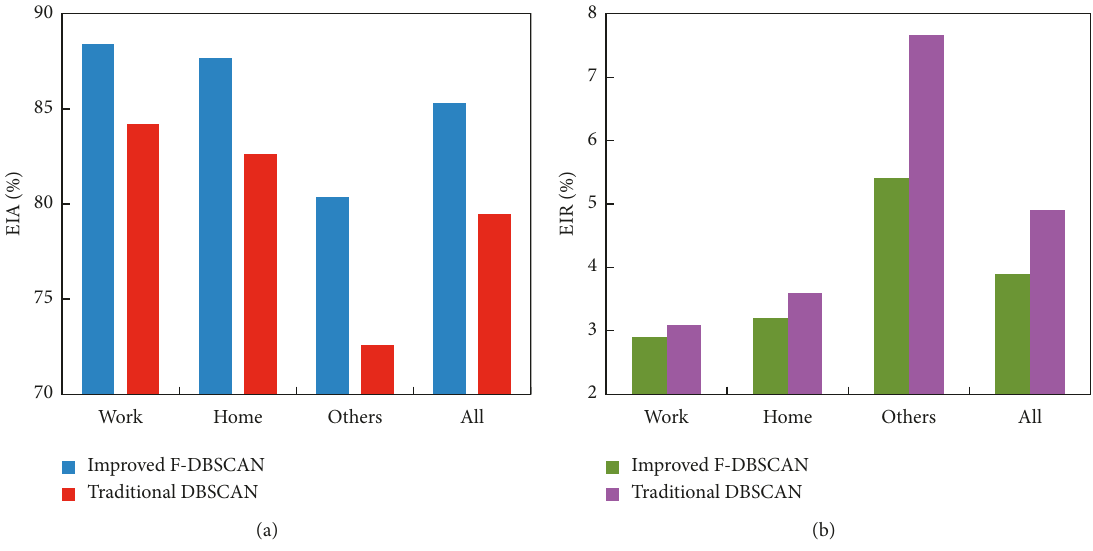
Figure 16: Identification accuracy of different types of trip ends. (a) EIA. (b)